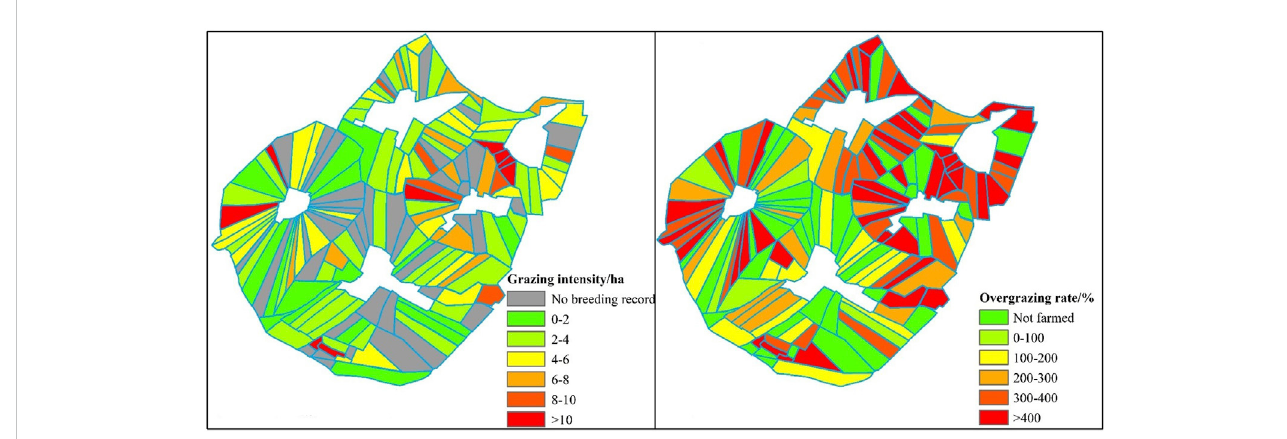
FIGURE 8 Schematic diagram of grazing intensity and overload rate in Wanjigou region in 2020.